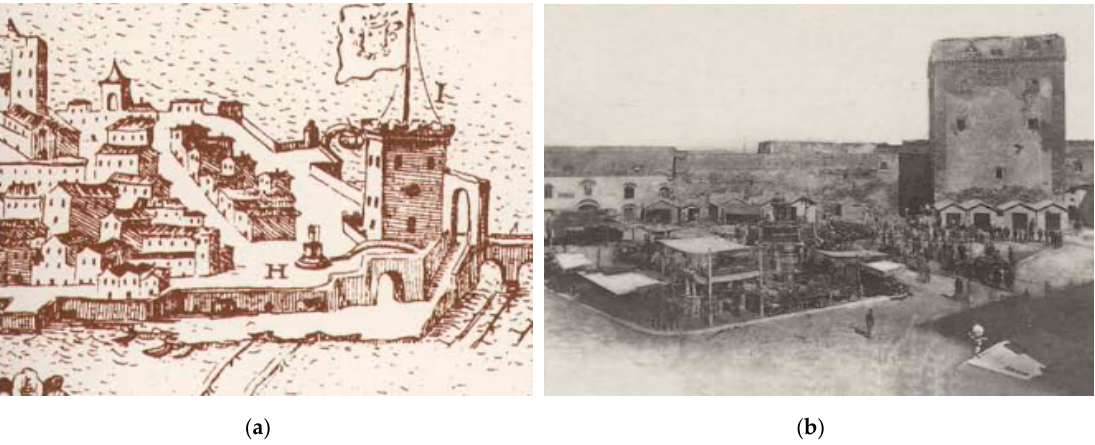
Figure 7. Iconographic reconstruction of Piazza Fontana: ( a ) the square in 1703; ( b ) in 1893.